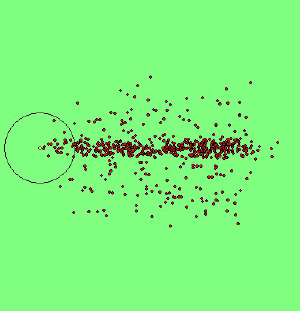
Figure 8. Position of nodes in the search model: after 20 steps